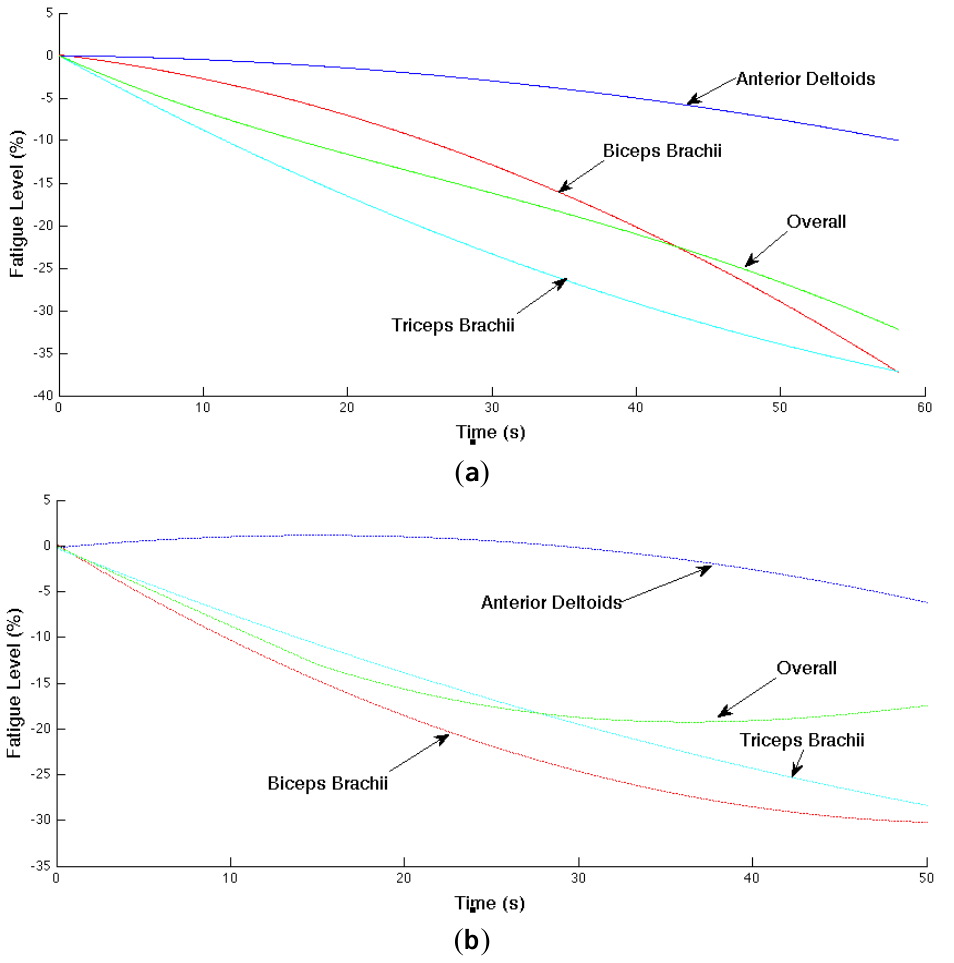
Figure 9. Overall fatigue level computed by localized fatigue levels of biceps brachii, anterior deltoids, and triceps brachii. ( a ) Experiment 1. ( b ) Experiment 2. The overall fatigue level starts around 0%, decreases gradually to − 32% and − 17%, in Experiments